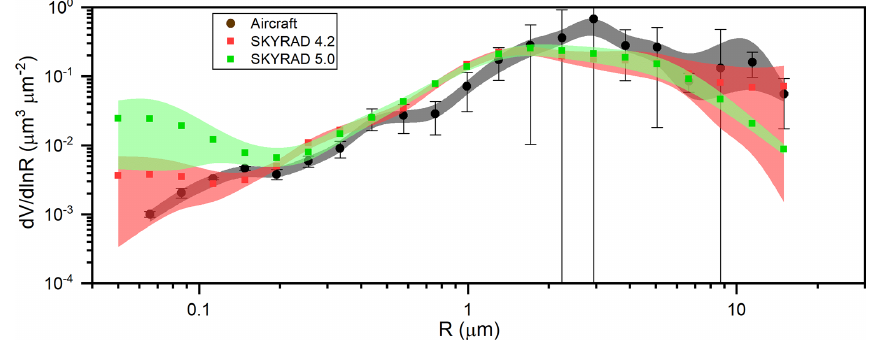
Figure 10. Retrieved and observed aerosol size distribution functions in the African dust event cases in the sun photometer Airborne Val- idation Experiment in Dust (SAVEX-D) campaign during 16–25 August 2015 (Estellés et al., 2018; Marenco et al., 2018; Ryder et al.,